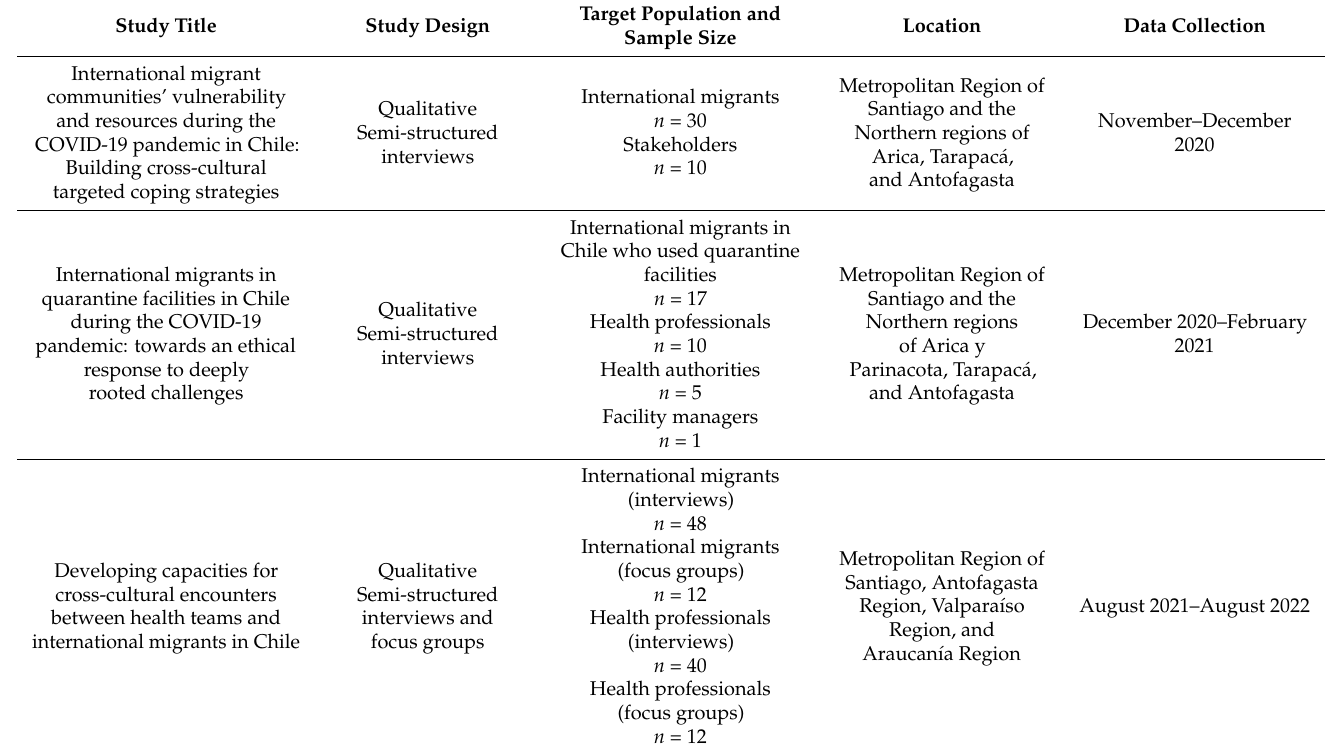
Table 1. General description of the research